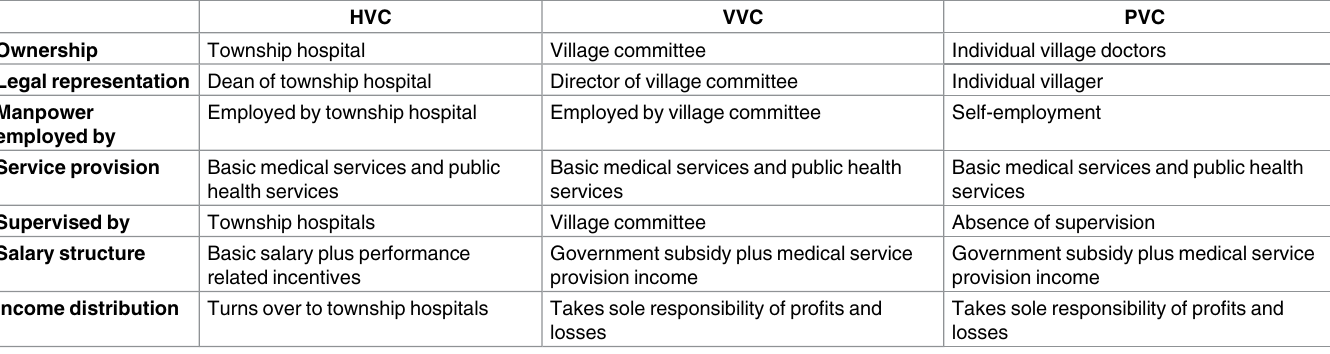
Table 1. Models of organization and management of village clinics.